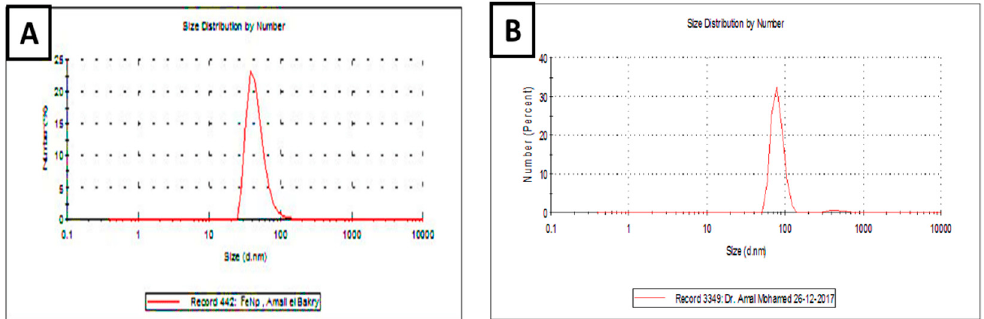
Figure 3. Size distributions of IONPs synthesized chemically ( A ) or using Petroselinum crispum leaf extract ( B ) in colloids. Size distribution of the particles was estimated from laser particle analyzer (LPA) images by measurement of diameters provided by the computer programming system of Zetasizer (Nano ZS, Malvern, UK).